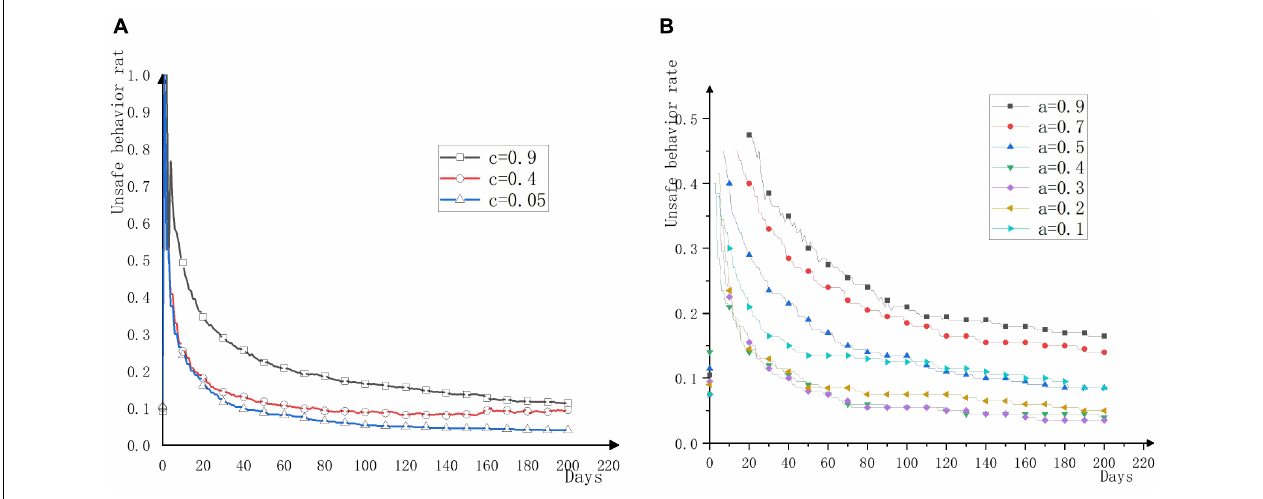
FIGURE 4 | Evolution Trend of unsafe behavior rate under the action of conformity mentality and formal rule awareness. (A) Evolution trend of unsafe behavior rate under the action of conformity mentality alone. (B) Evolution trend of unsafe behavior rate under the action of formal rule awareness